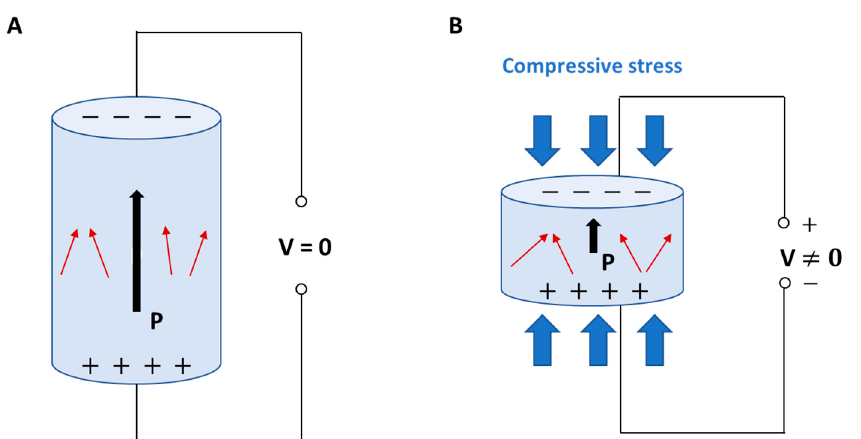
Figure 1. Direct piezoelectric effect in a biomaterial element: ( A ) without external stress, and ( B ) subject to compressive stress with charge generation. P: polarization vector; V: voltage; red arrows: dipoles; black arrows: direction of polarization vector.